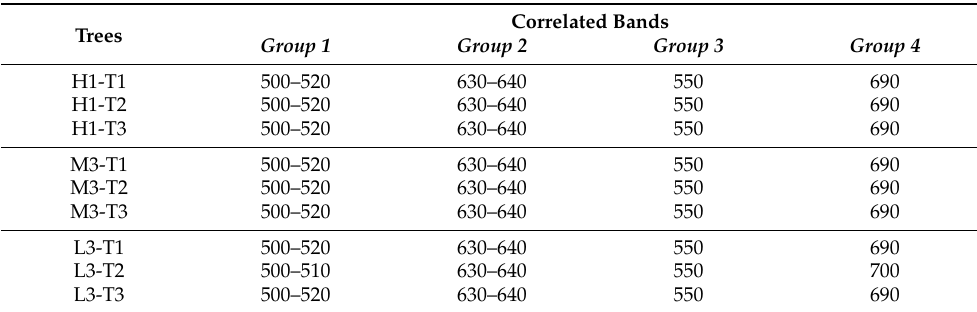
Table 3. Summary of the dominant wavelength in nm for the high, medium, and low potassium peach trees.